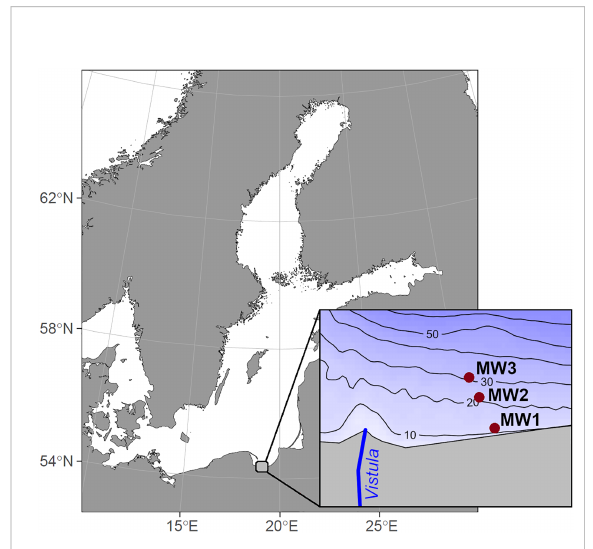
FIGURE 1 Map of the study area with sampling stations, overview map of the Baltic Sea region in the